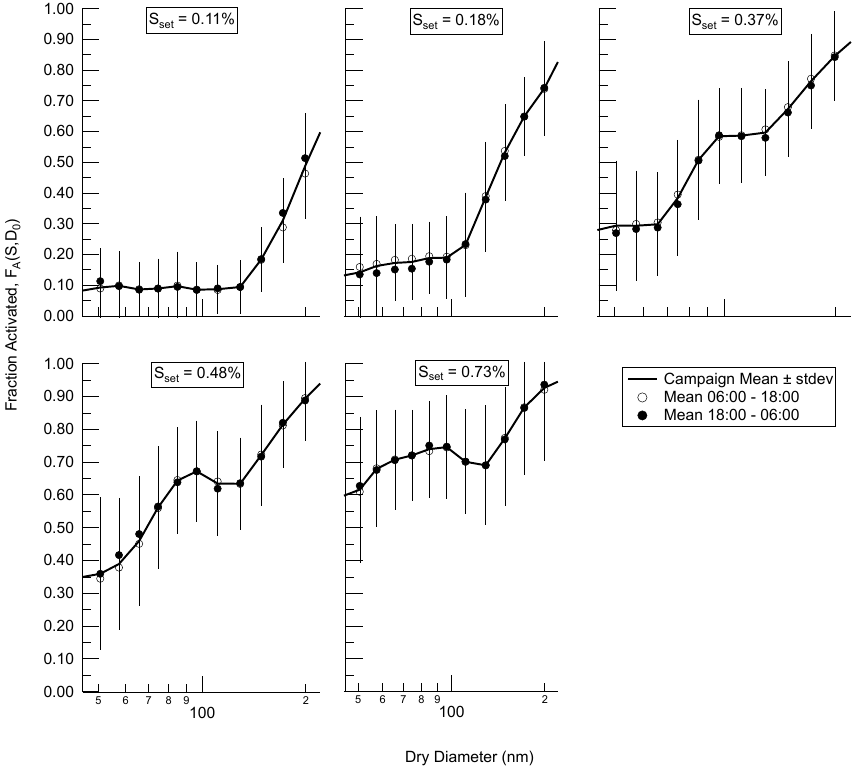
Fig. 2. The aerosol fraction activated F A ( S , D 0 ) against dry diameter, for each S set used in OP3-III. The campaign mean is shown as a solid black line, with error bars illustrating the standard deviation. The data was segregated into day and night, denoted by hollow and solid circles